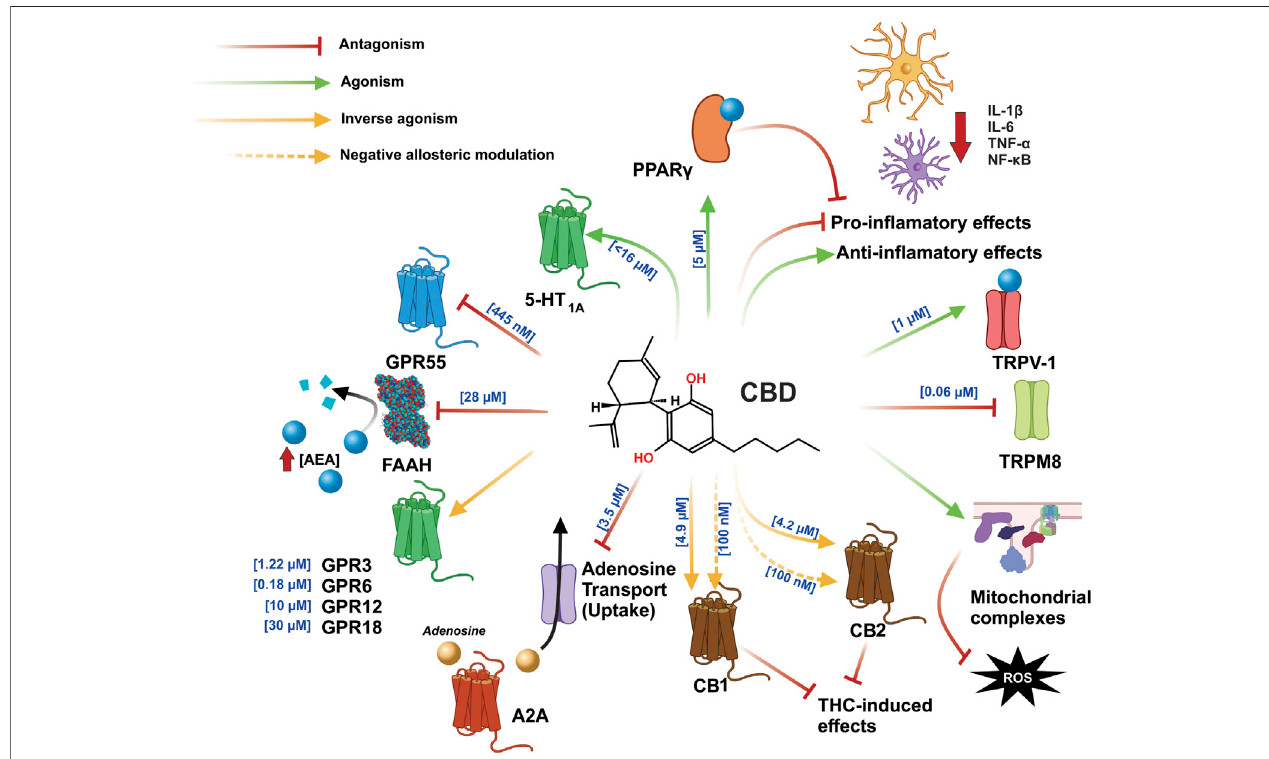
FIGURE 3 | CBD exerts an agonist-like effect on the PPAR γ , TRPV1, CB1, and CB2 receptors, by inhibiting the enzyme that degrades AEA and FAAH, leading to increased AEA concentration and greater interaction with said receptors. In addition, CBD inhibits GPR55 and TRPM8 and exerts an effect as an inverse antagonist on the GPR3, GPR6, GPR12, CB1, and CB2 receptors; moreover, in CB1 and CB2, it can function as a negative allosteric modulator, which is involved in blocking the effects of THC. The anti-in fl ammatory effects of CBD function by directly decreasing the synthesis of pro-in fl ammatory cytokines and increasing the synthesis of anti-in fl ammatory cytokines. CBD also reduces in fl ammation by stimulation PPAR γ . Part of its antioxidant effects are achieved via the increased activity of mitochondrial complexes I, II, II-III, and IV. Abbreviations: CBD, cannabidiol; PPAR γ , peroxisome proliferator activated receptor γ ; TRPV1, transient potential receptor V1; CB1, cannabinoid receptor type 1; CB2, cannabinoid receptor type 2; AEA, anandamide; FAAH, fatty acid amide hydrolase; GPR55, G protein coupled receptor 55; TRPM8, transient potential receptor M8; GPR3, G protein coupled receptor 3; GPR6, G protein coupled receptor 6; GPR12, G protein coupled receptor 12; THC,